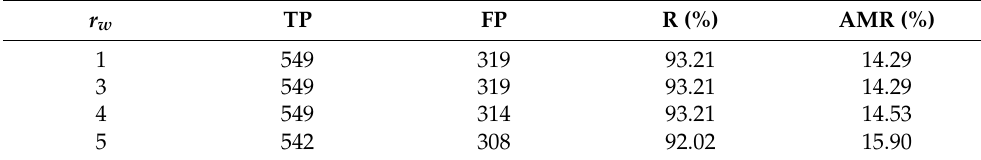
Table 2. Comparison of different r w values in the integrated detector.